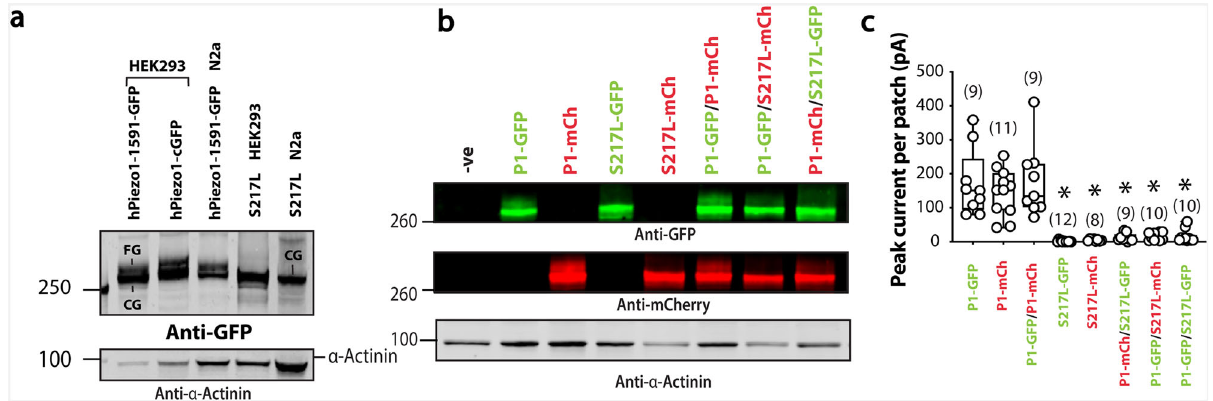
Fig. 8 Comprehensive analysis of co-expression of S217L Piezo1 and WT Piezo1 fused to GFP and mCherry. a Representative western blot of Piezo1-GFP and S217L expressed in HEK293 and Neuro2a cells (N2a). b Representative western blot of Piezo1-GFP, Piezo1mCherry, S217L-GFP, S217L-mCherry, and co-expression of Piezo1-GFP/Piezo1-mCherry, Piezo1-GFP/S217L- mCherry, Piezo1-mCherry/ S217L-GFP. The GFP and mCherry signal are shown separately. c Quanti fi cation of peak current elicited per patch of all combinations expressed in Piezo1 -/- HEK293T cells. Asterisk (*) denotes statistical